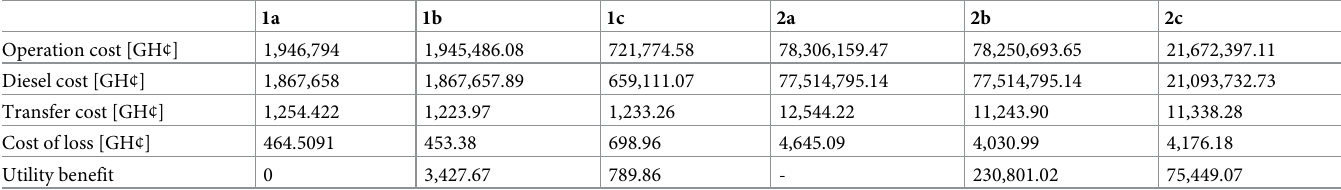
Table 10. Finances associated with each